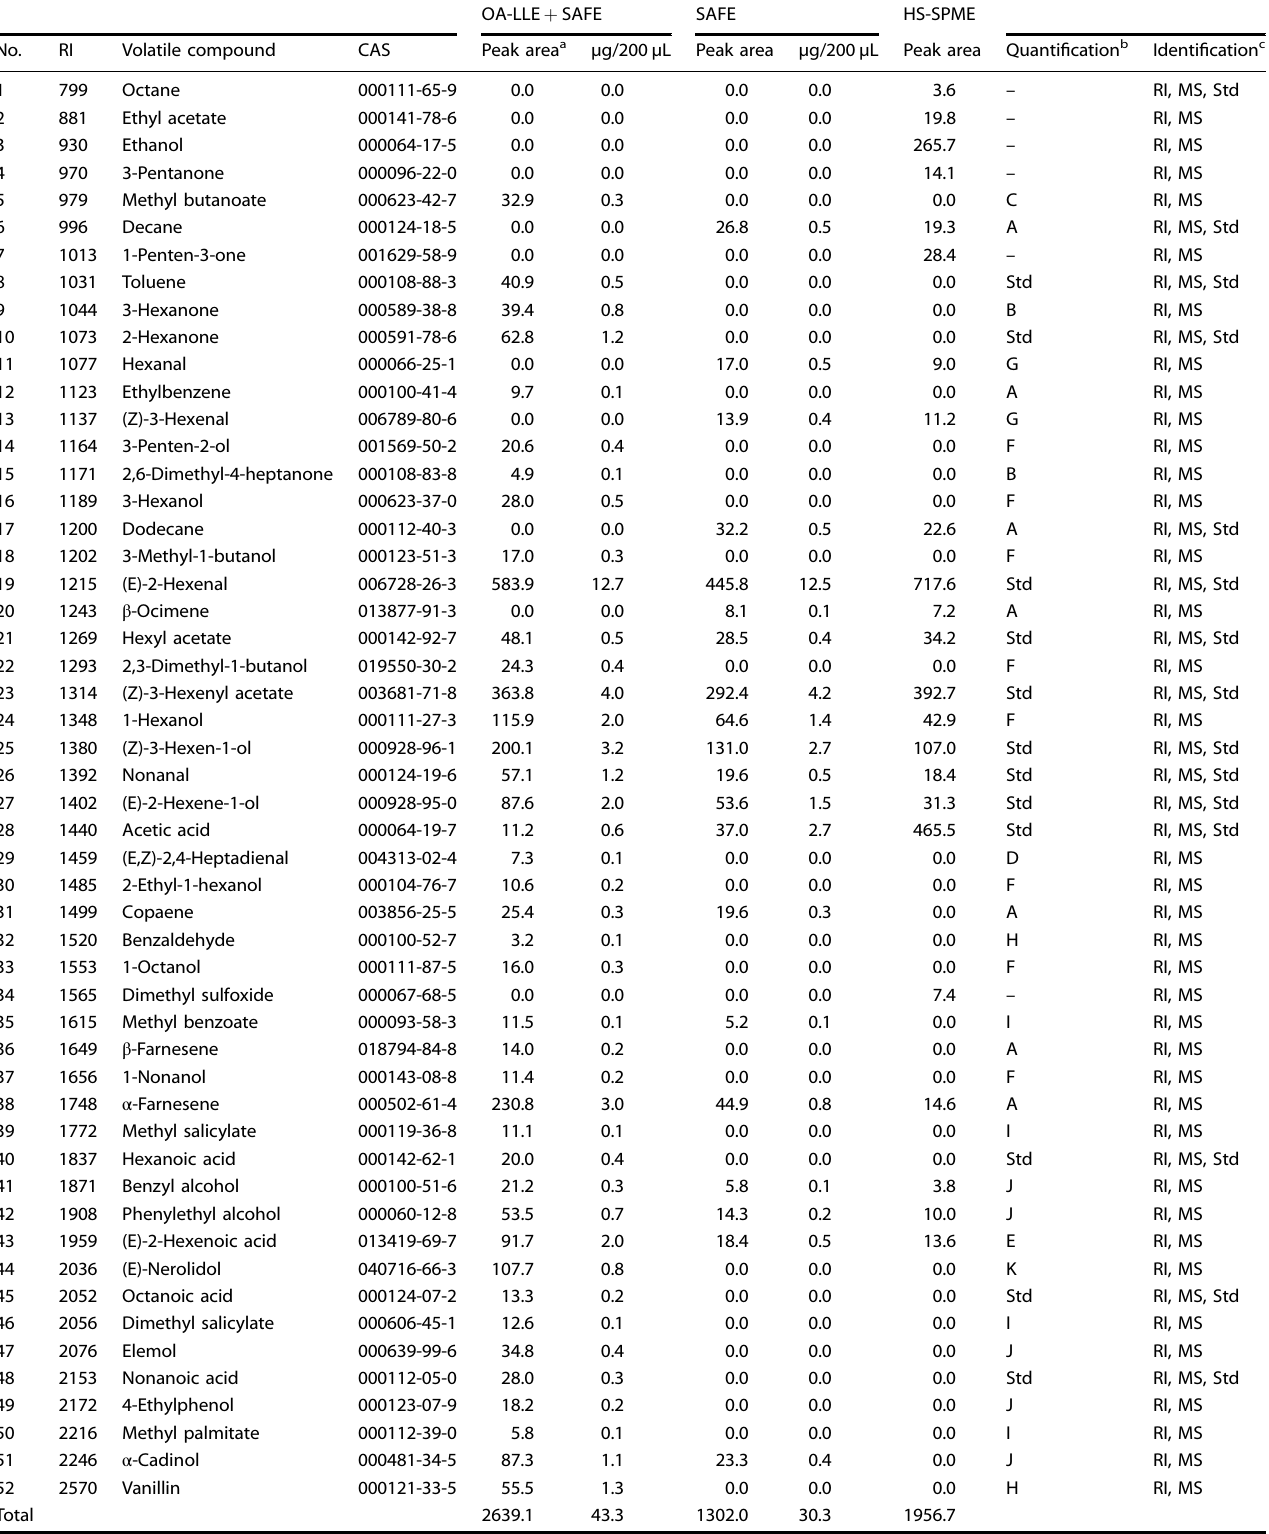
Table 2. Volatile compounds identi fi ed in